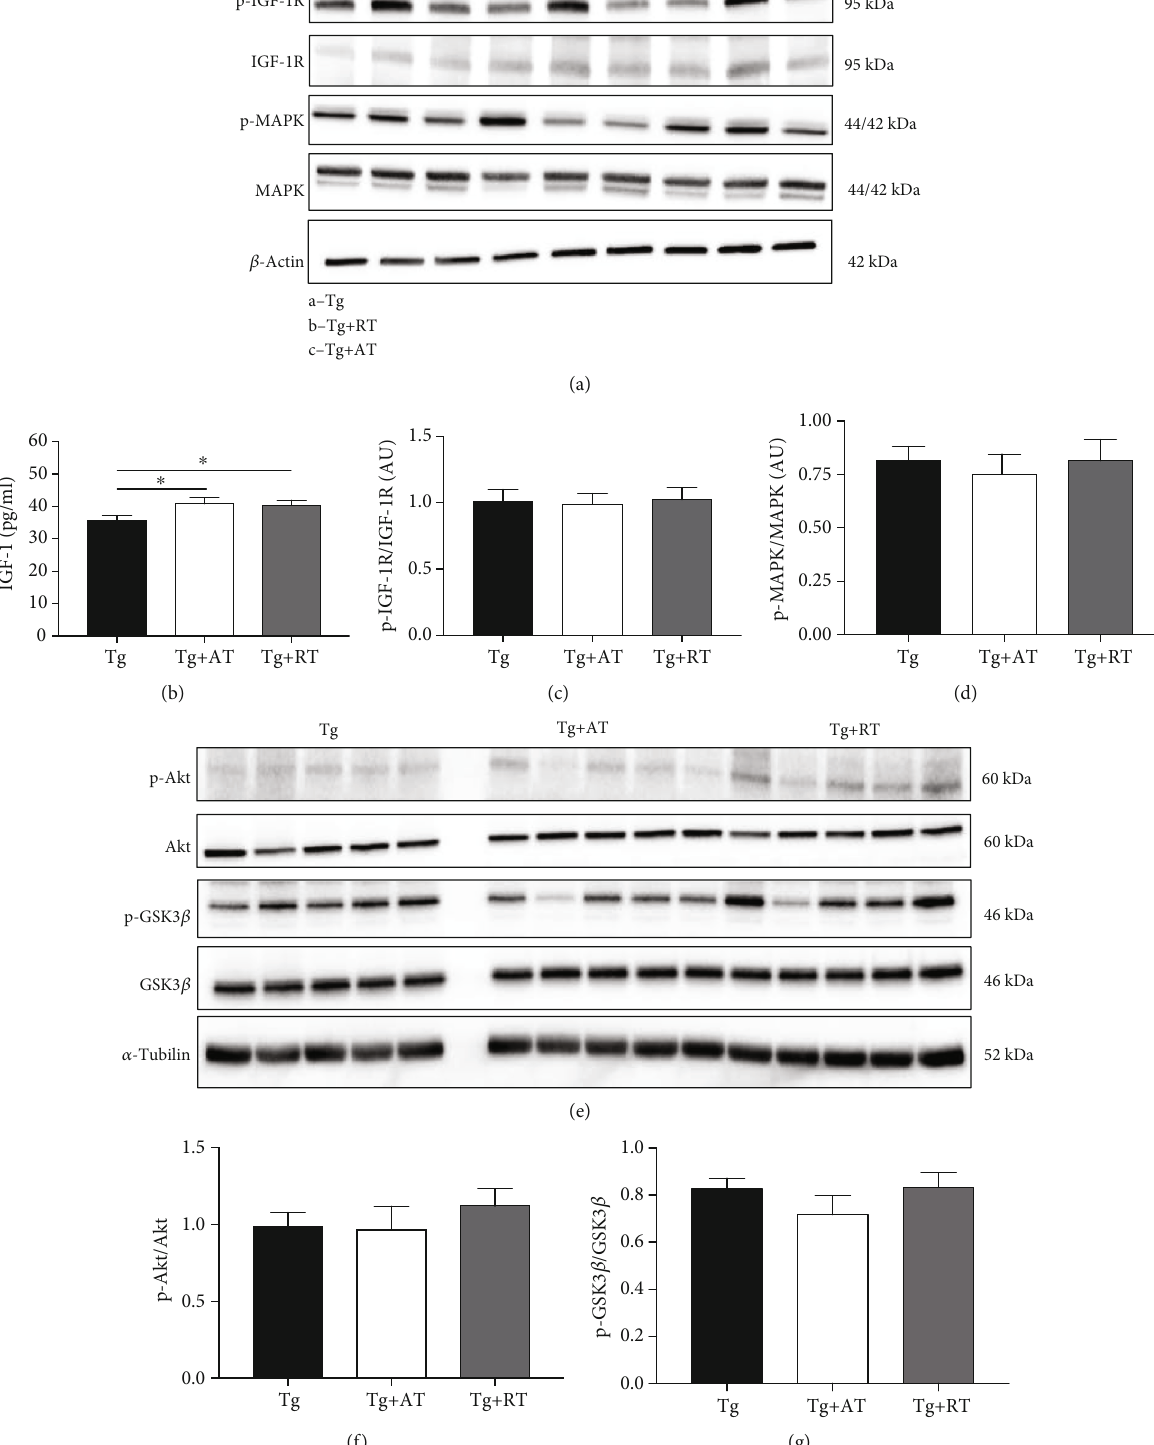
Figure 5: IGF-1 expression and signaling in the hippocampus of exercise-trained 3xTg-AD mice. (a) Representative immunoblots for IGF-1R and MAPK. (b) IGF-1 concentration in hippocampal homogenate measured by ELISA. (c) p-IGF-1R normalized to total IGF-1R. (d) p- MAPK normalized to MAPK. (e) Representative immunoblots for Akt and GSK3 β . (f) p-Akt normalized to Akt. (g) p-GSK3 β normalized to total GSK3 β . Data presented as mean ± SE . Tissues assayed from the nonexercised group (Tg), the aerobic-trained group (Tg+AT), or the resistance-trained group (Tg+RT) ( n = 10 /group). Di ff erences determined by one-way ANOVA. ∗ p < 0 : 05 and ∗∗ p < 0 : 01